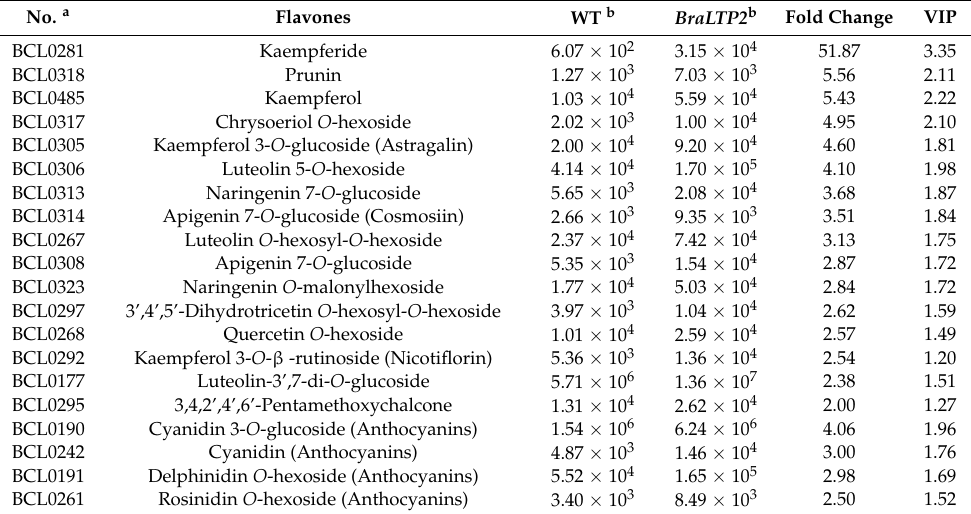
Table 3. Difference of flavones in the wild type and 35::BraLTP2- overexpressed lines. VIP—variable important in projection.